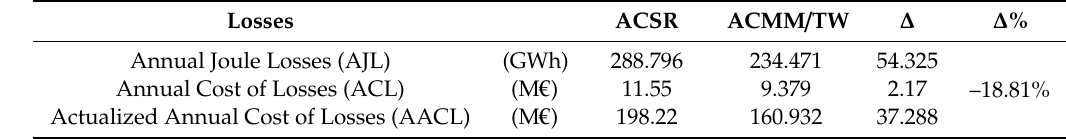
Table 12. Comparison between traditional and innovative conductors for HV